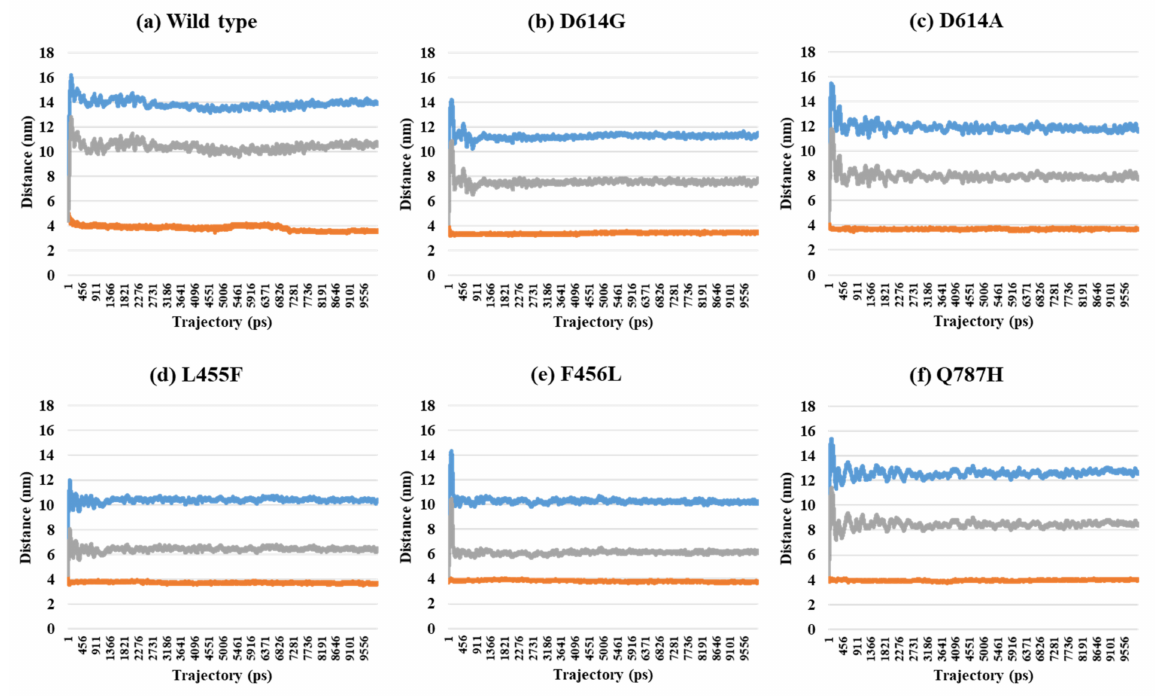
Figure 3. Distance between V503 residues in two chains depending on MD trajectories in the 2-open-complex form (7A97). ( a ) Wild type, ( b ) D614G, ( c ) D614A, ( d ) L455F, ( e ) F456L, and ( f ) Q787H. The X axis denotes trajectory (ps), and the Y axis denotes distance (nm). Blue color indicates the distance between A and B, orange indicates A–C distance, and gray indicates distance between B and C.